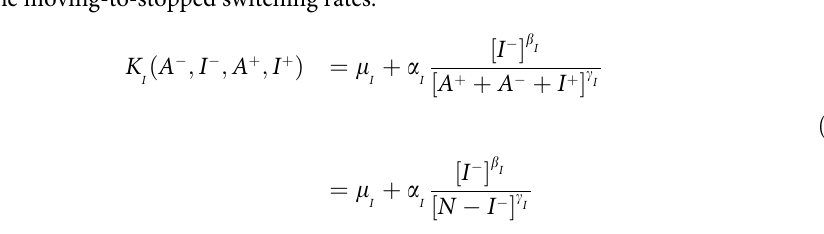
Table 1. Individual parameters for the double mimetic effect. Parameter Stopped-to-Moving Kept Moving-to-Stopped Kept